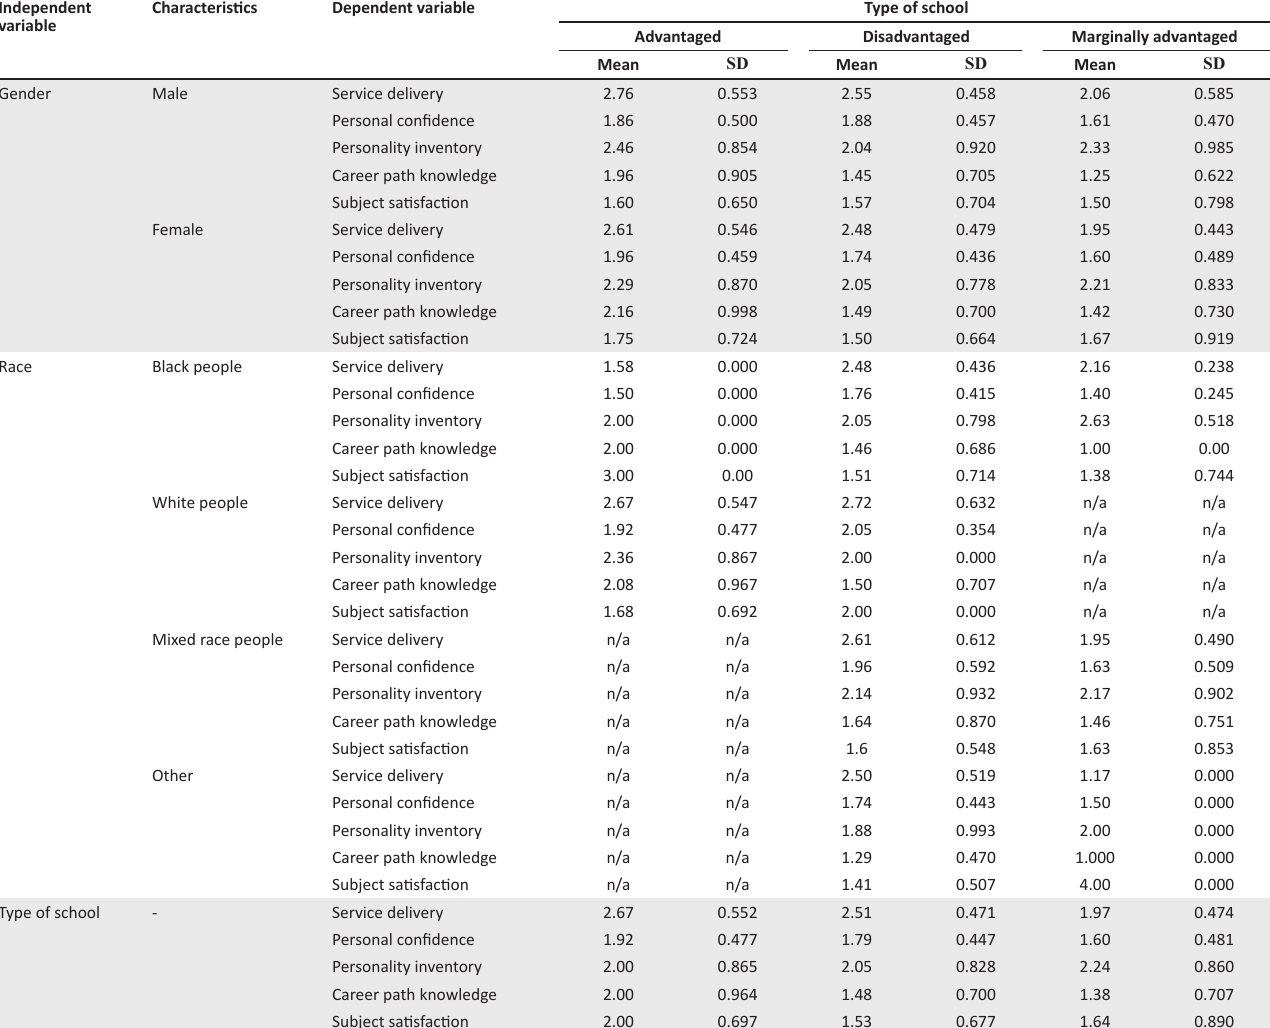
TABLE 3: Measures for central tendency with reference to the independent and dependent variables per type of school. Independent variable